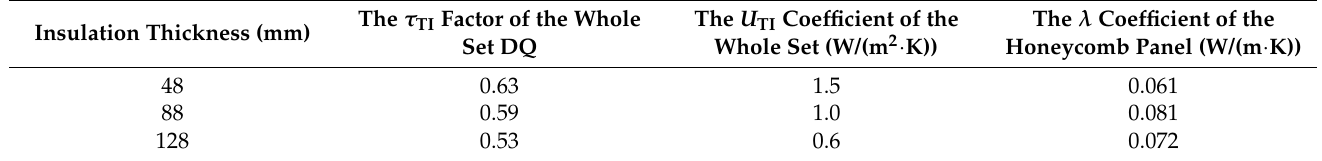
Table 1. Properties of transparent insulation (on the basis of data from